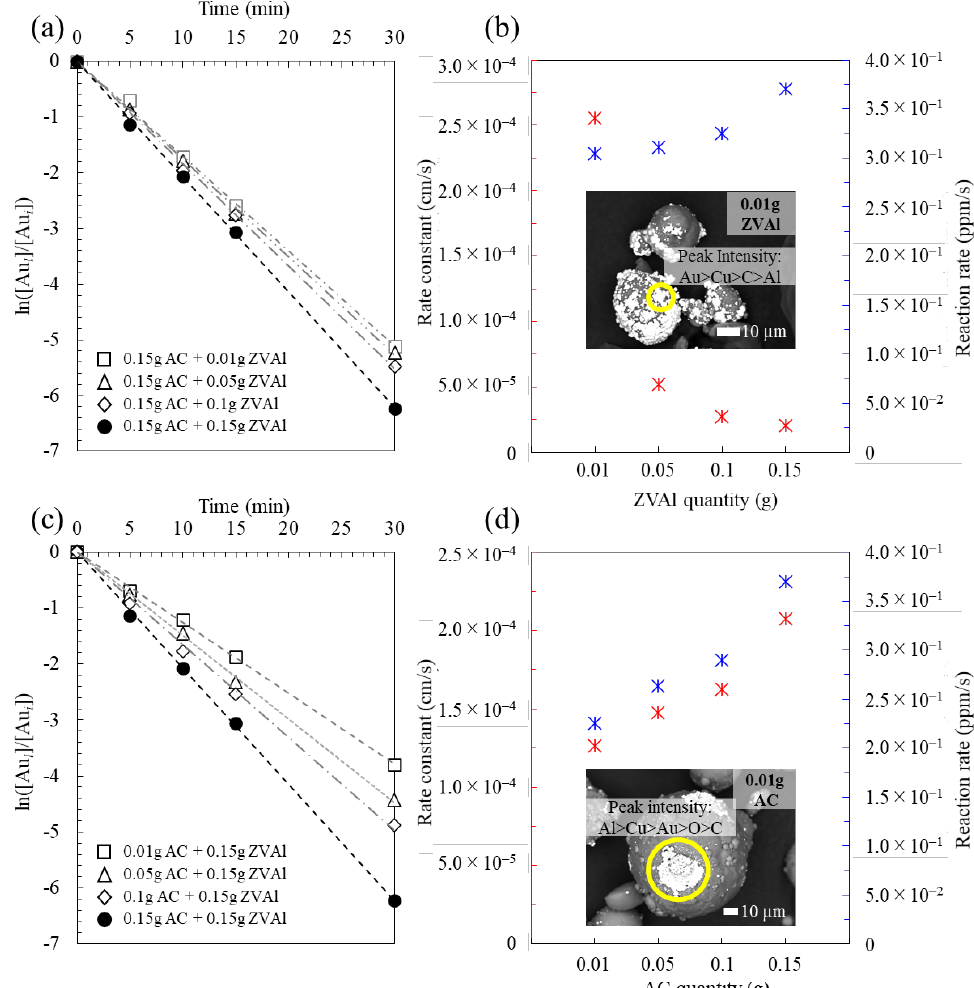
Figure 4. The effects of ( a ) Al and ( b ) AC quantity on recovery of Au ions, and the plot of rate constant/rate vs ( c ) Al and ( d ) AC quantity for the cementation reaction by galvanic interaction of Al and AC in an ammonium thiosulfate system (Note that reaction rate has a minus value).